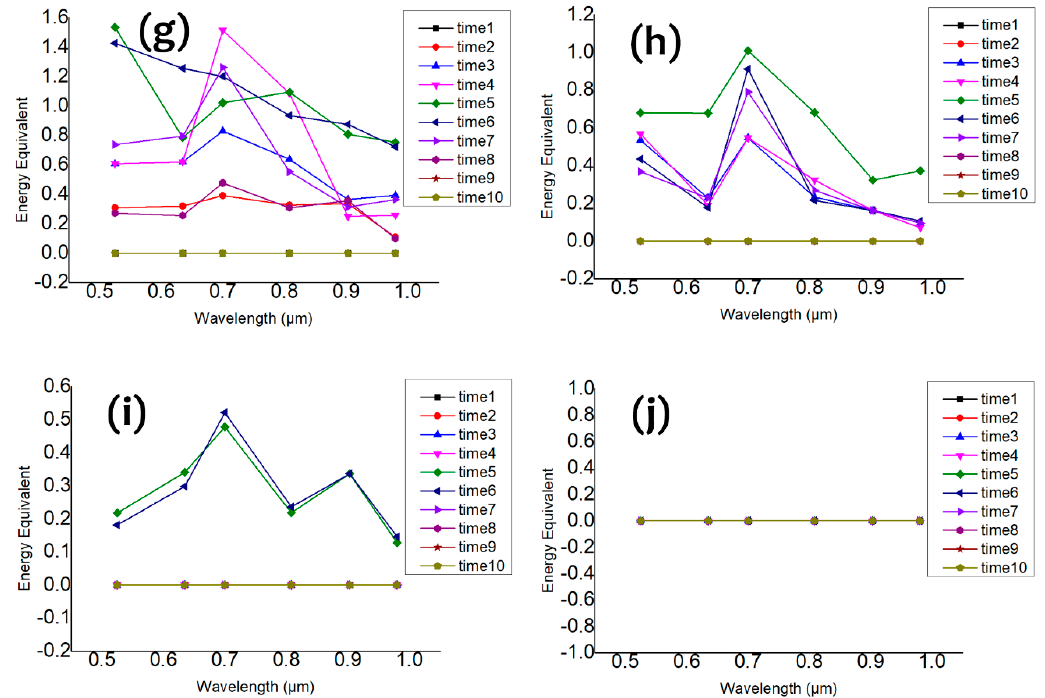
Figure14. Theenergyequivalentofthehigh-temperaturefurnace( a – j ), respectively, fortarget1–target10. Figure 14. The energy equivalent of the high-temperature furnace ( a – j), respectively, for target1– target10. Table 2. The true temperature measurement results. Table 2. The true temperature measurement results. True Temperature of Each Target /